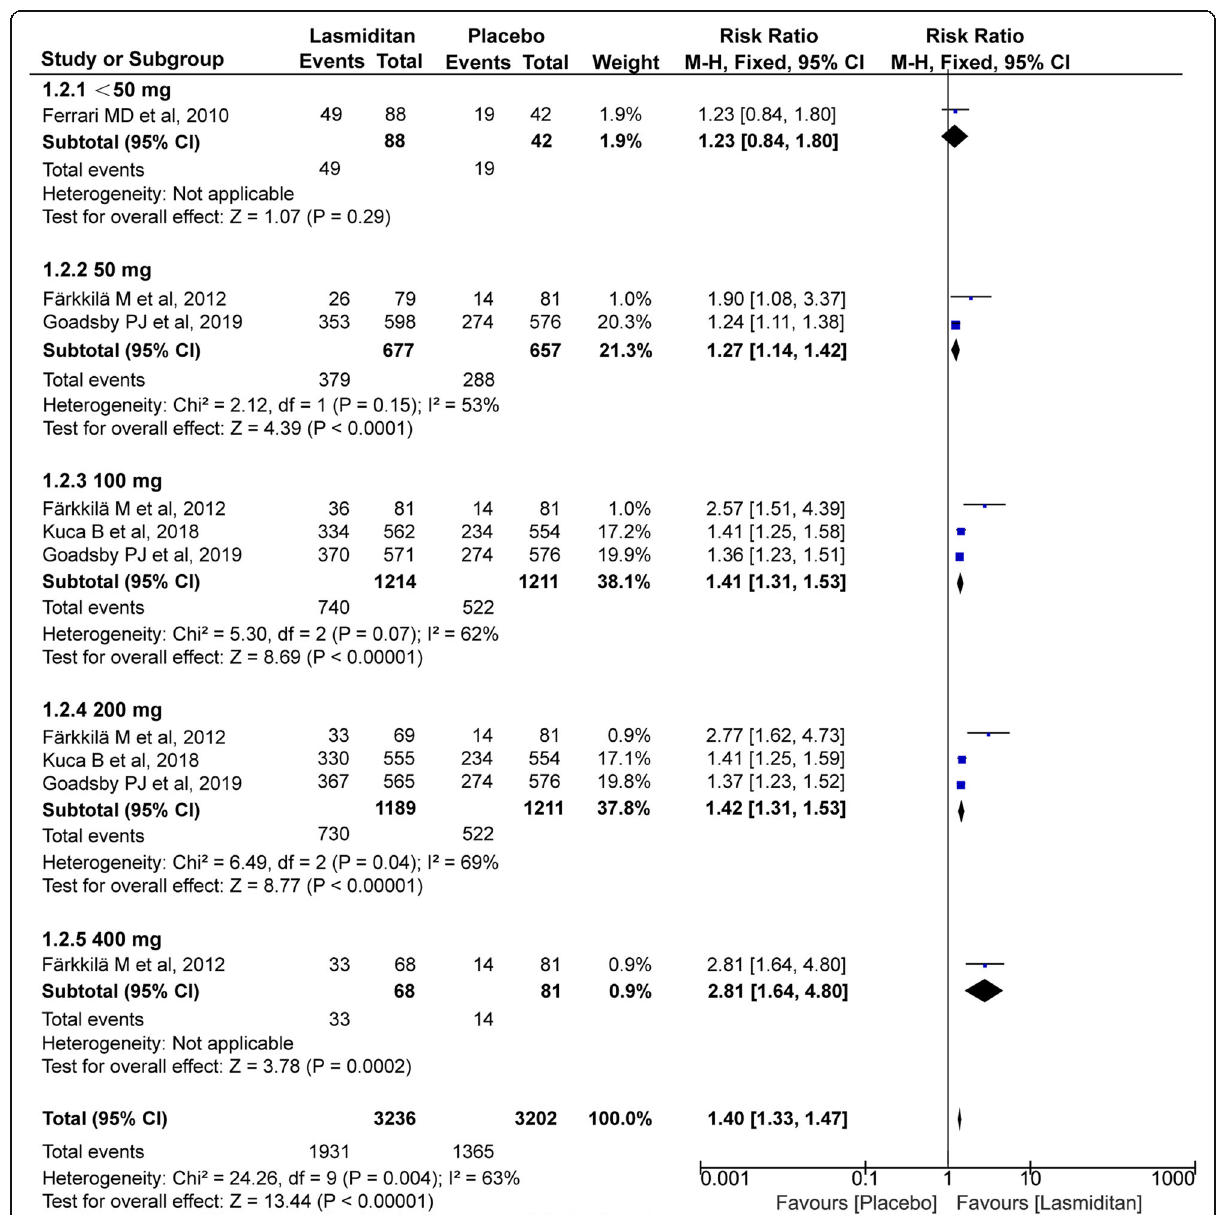
Fig. 4 Meta-analysis of the pain relief at 2 h after therapy with lasmiditan compared with placebo. The diamond indicates the estimated relative risk with 95% confidence interval for the pooled patients. M-H, Mantel-Haenszel; CI, confidence